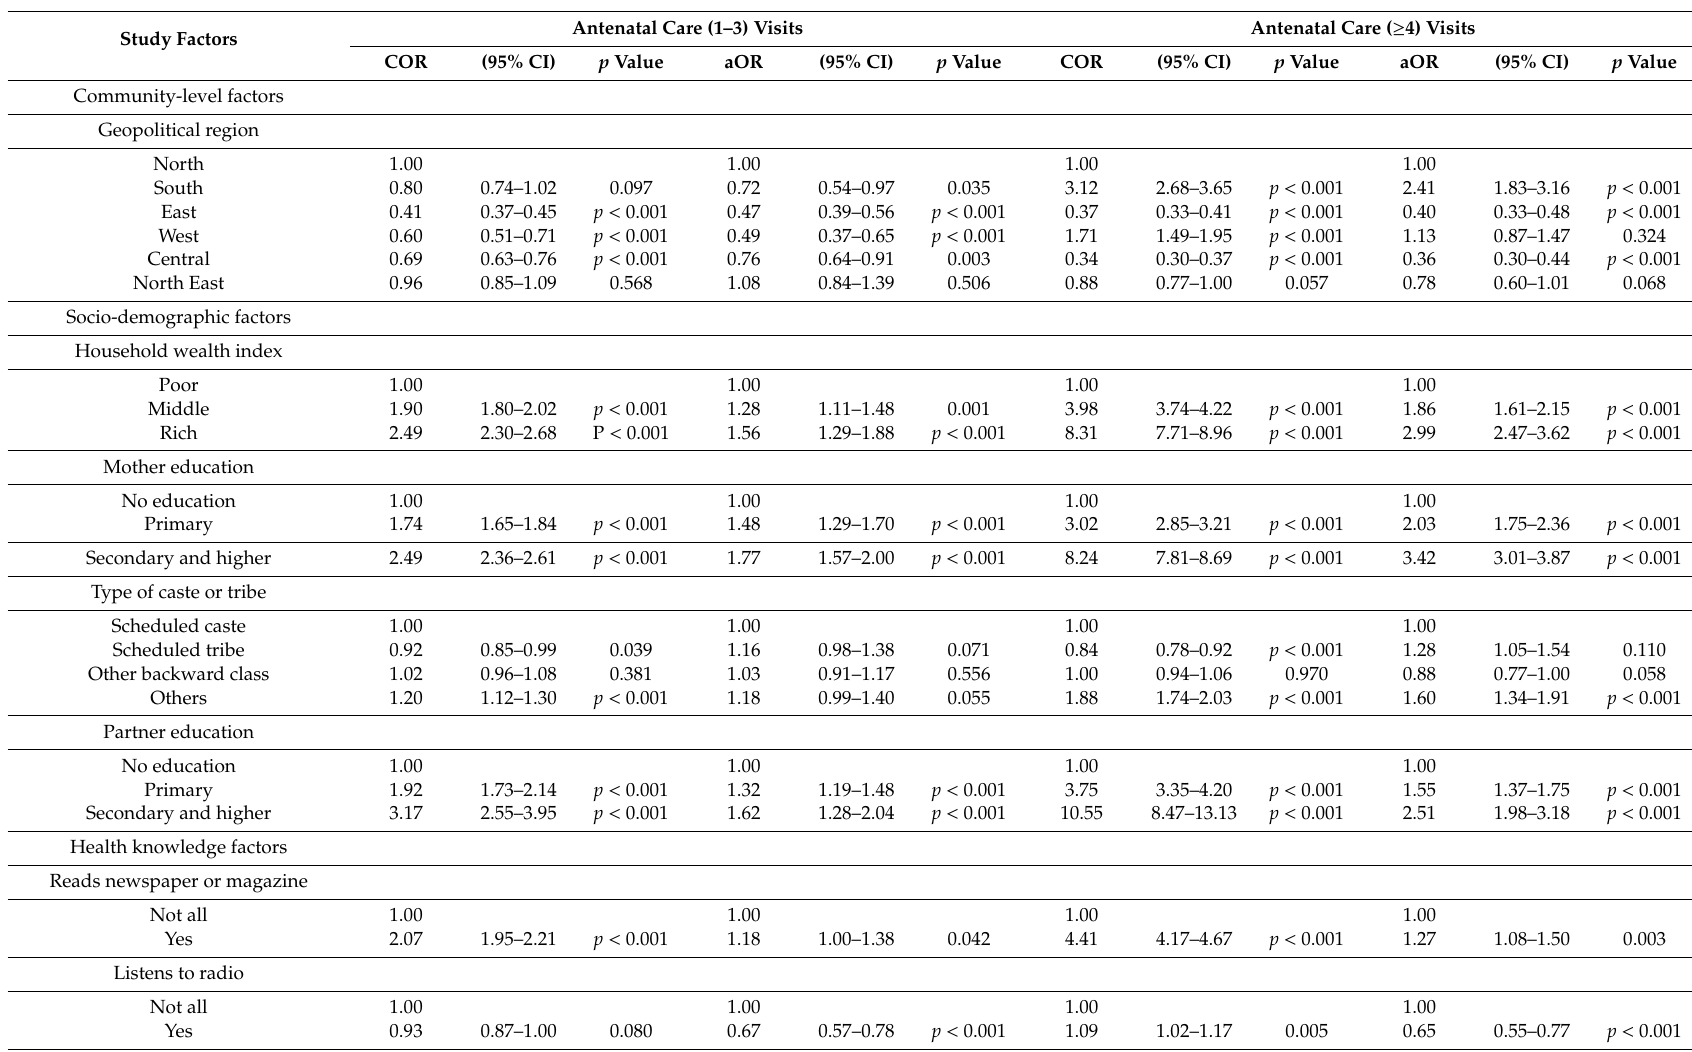
Table 2. Factors associated with antenatal care service use in India, 2015–2016 NFHS ( N =